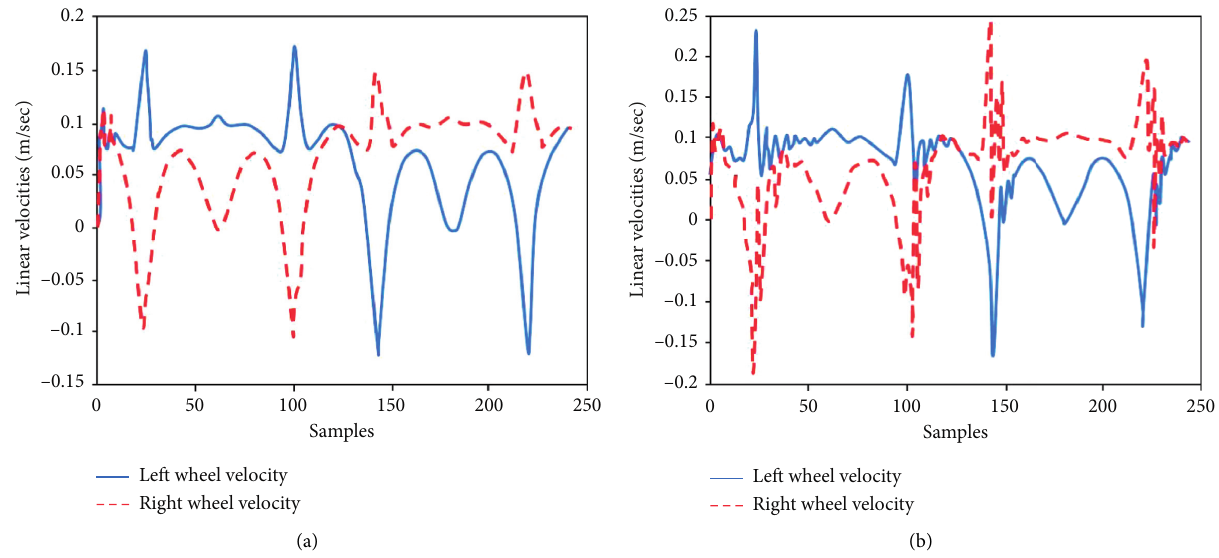
Figure 11: The left and right wheels’ velocity of DDMR for lemniscates trajectory with (a) NNFOPID controller and (b) NNPID